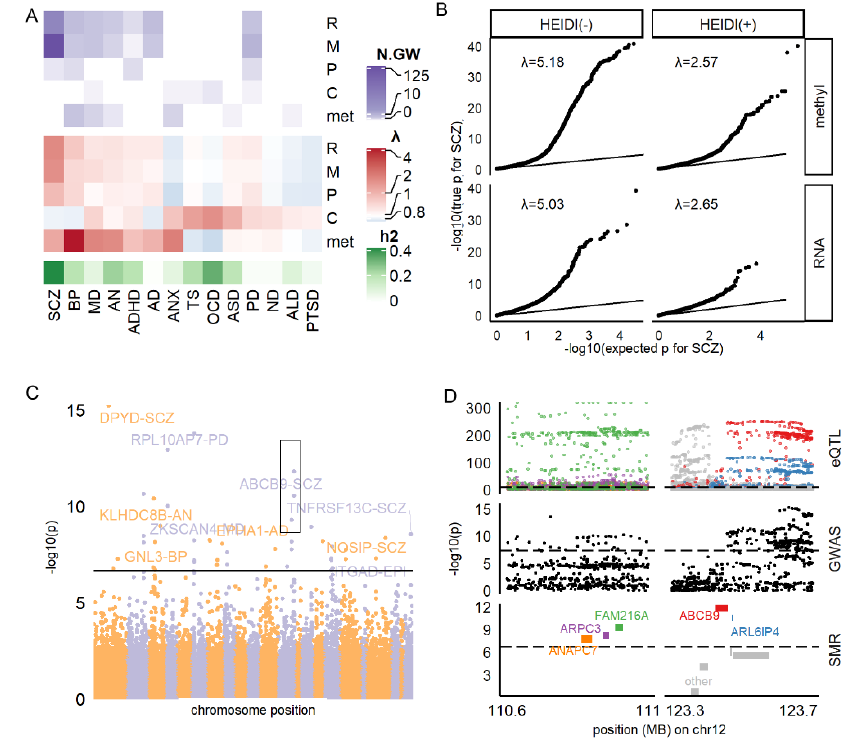
Figure 1. Summary of SMR results. ( A ) Number of HEIDI(+) molecules reaching genome-wide significance (N.GW; top panel) and inflation factor (middle panel) for each omic and disease. SNP- based heritability (h2) was estimated by Linkage Disequilibrium Score Regression. ( B ) QQ plot for SMR result of RNA-SCZ and methylation-SCZ association. ( C ) Manhattan plot for the association between RNA and all diseases. ( D ) Regional GWAS, QTL, and SMR statistics for SCZ in distal 12q region (black box in ( C )) E: selected top molecules associated with multiple diseases. F: association between cytokines, metabolites, and diseases. R: RNA, m/methyl: methylation site. P: protein. C: cytokine. met: metabolite.